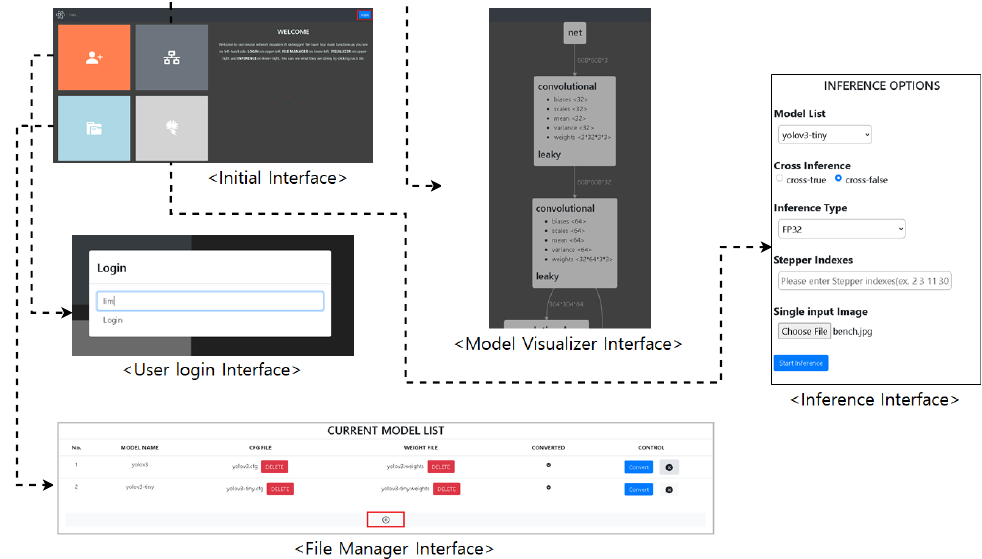
Figure 6. The initial interface of the framework and the arrangement of interfaces for each function: user login, visualizer, file manager, and